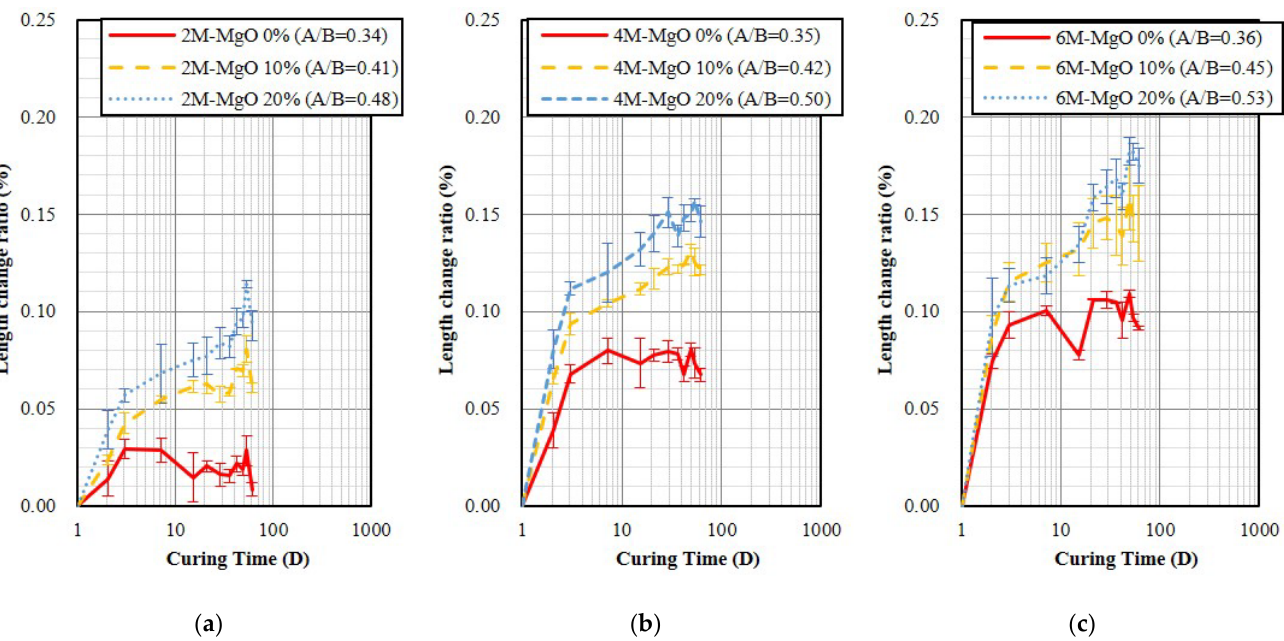
Figure 7. The length change ratios of the specimens demold at age of 24 h and then water bath curing. ( a ) 2 M; ( b ) 4 M; ( c ) 6 M.